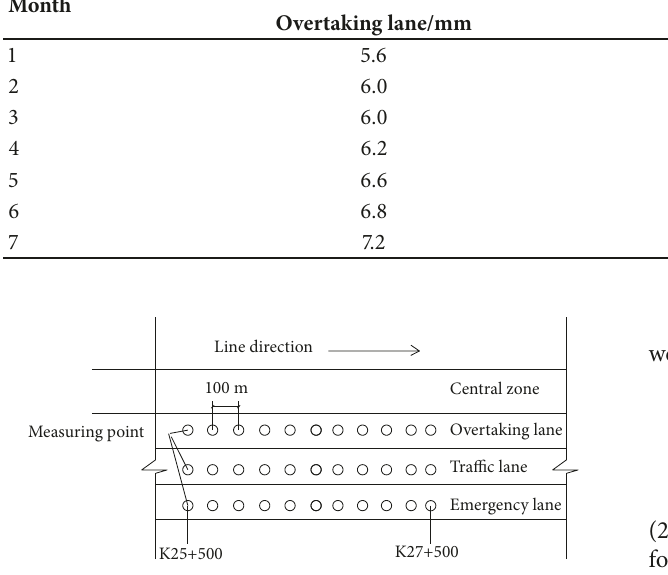
Figure 1: Layout of pavement performance measuring points.